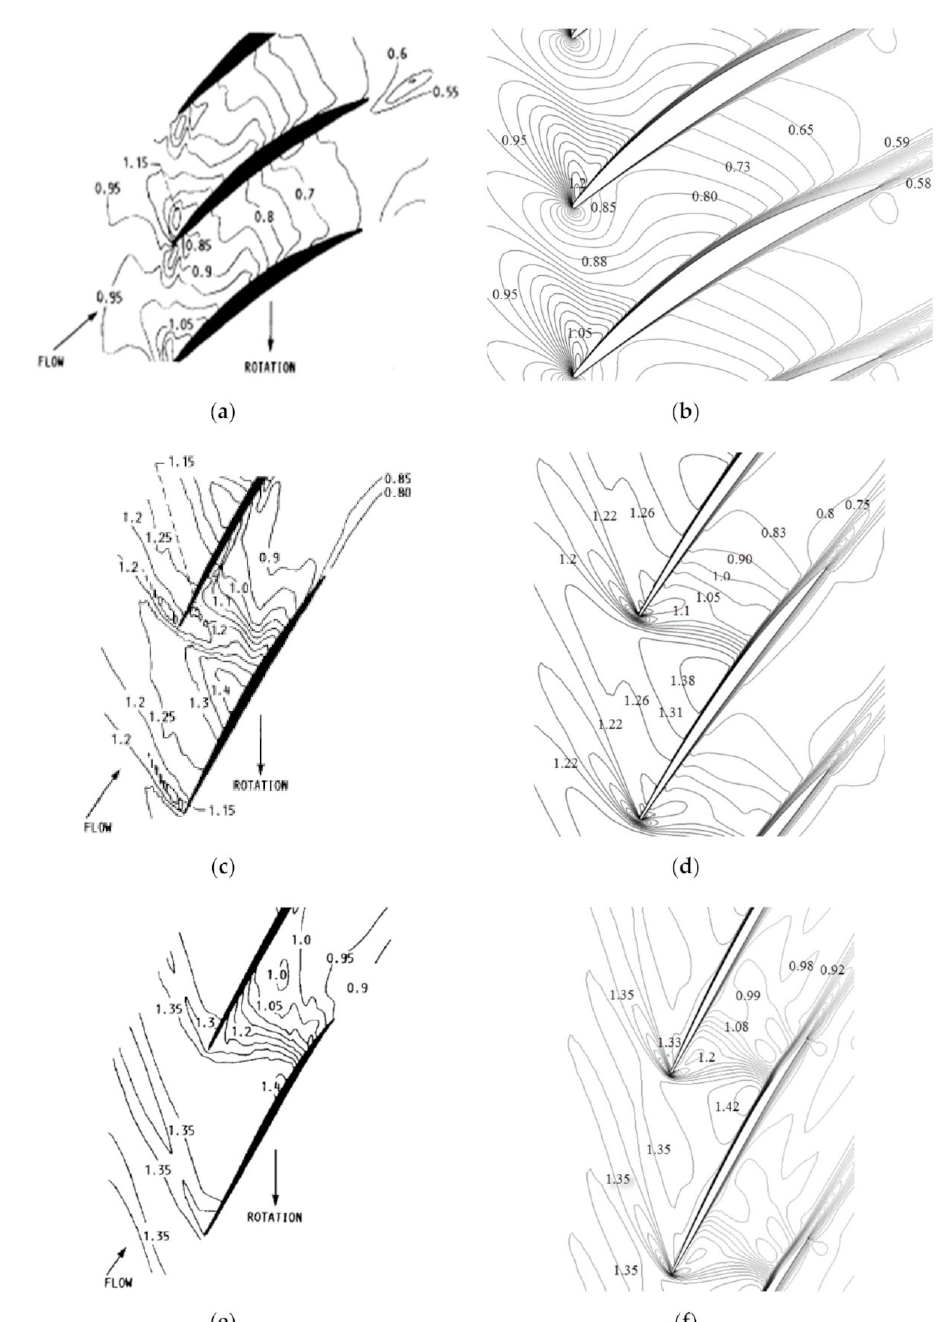
Figure 6. The Mach number (Ma) of the calculated and experimental value at the point of near peak e ffi ciency (NPE). ( a ) 30% Span Experiment; ( b ) 30% Span Computation; ( c ) 70% Span Experiment; ( d ) 70% Span Computation; ( e ) 90% Span Experiment; ( f ) 90% Span